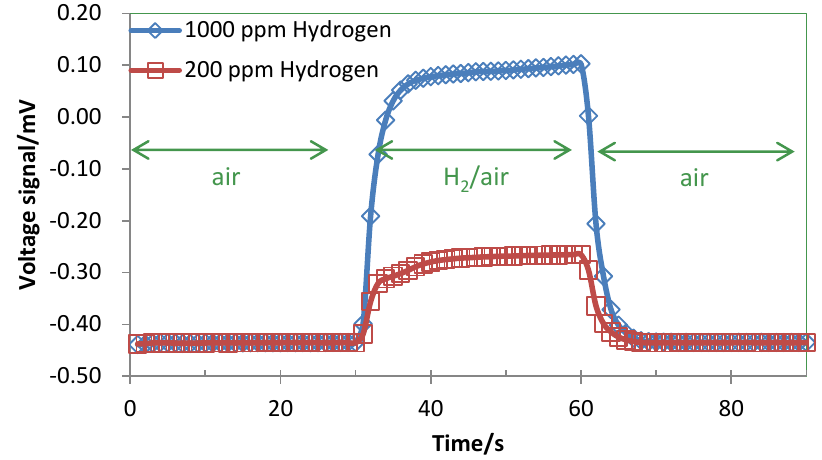
, measured A is 2.0 gas